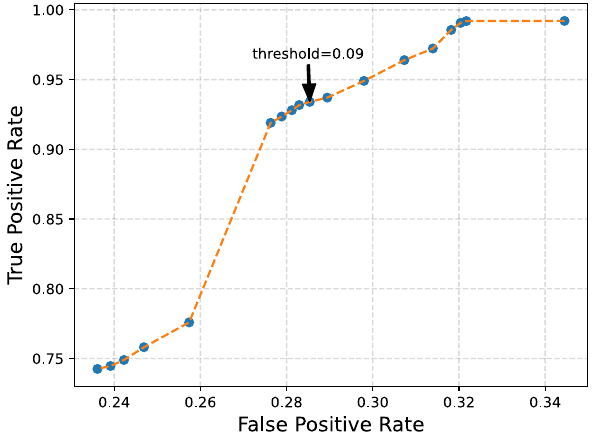
Figure 6. ROC curve diagram of IP link classification under different